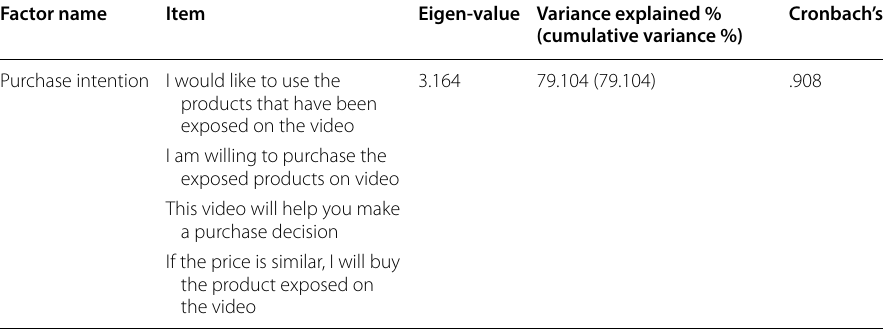
Table 4 The result of principal factor analysis for purchase